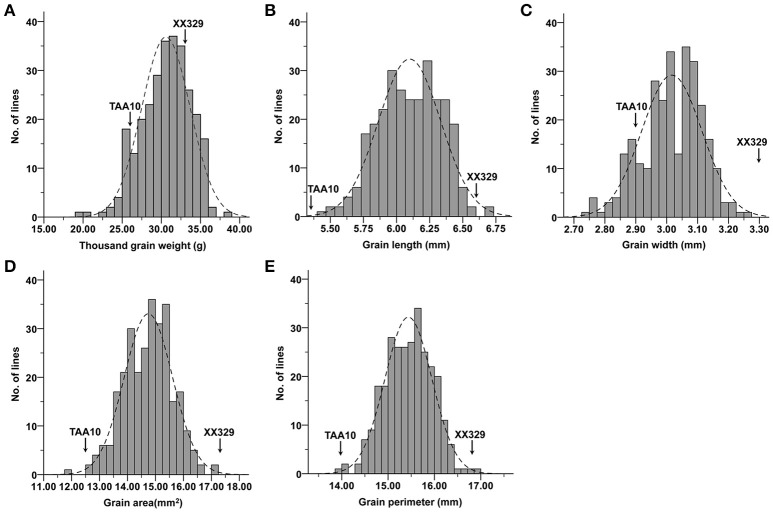
Frequency distributions for means of (A) thousand grain weight (TGW), (B) grain length (GL), (C) grain width (GW), (D) grain area (GA), and (E) grain perimeter (GP) in the F2:3 population.